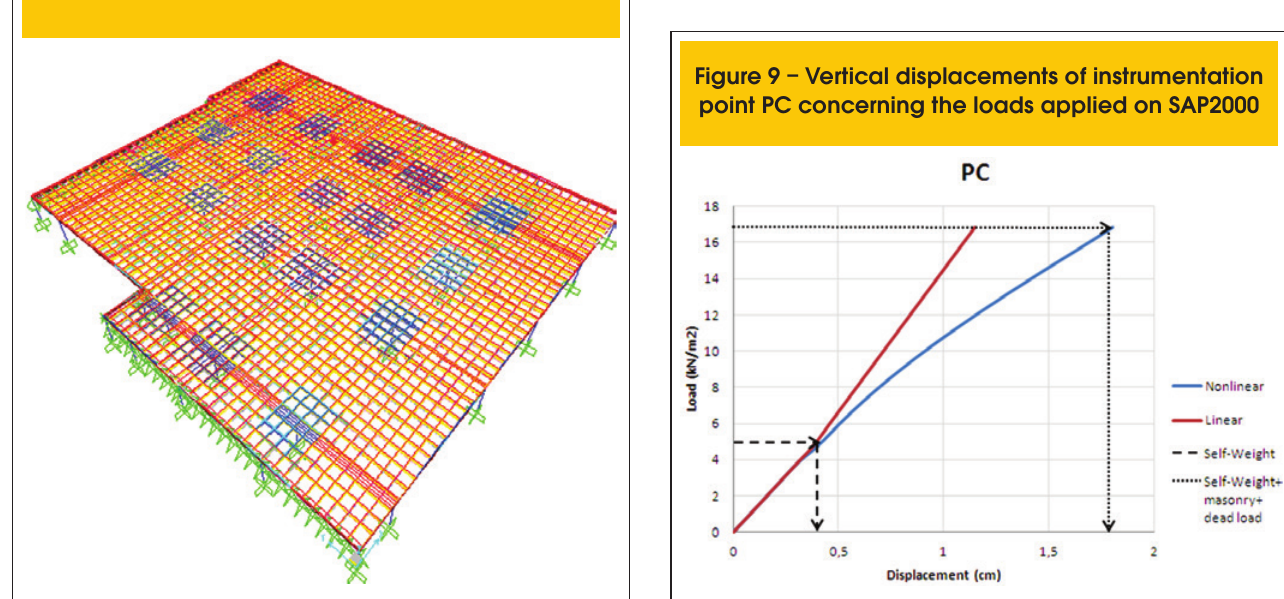
Figure 8 – Finite element model